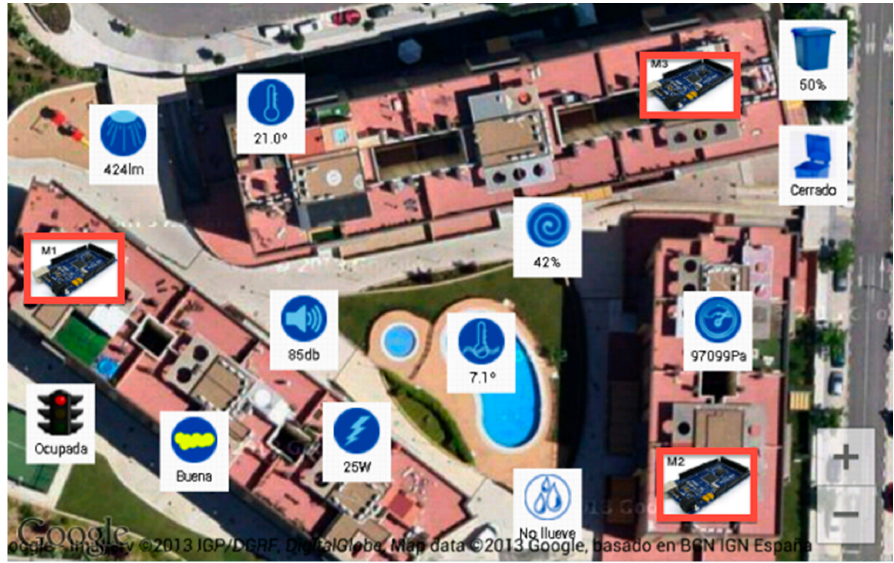
Figure 5. Location of sensors and microcontrollers in SmartResidents.